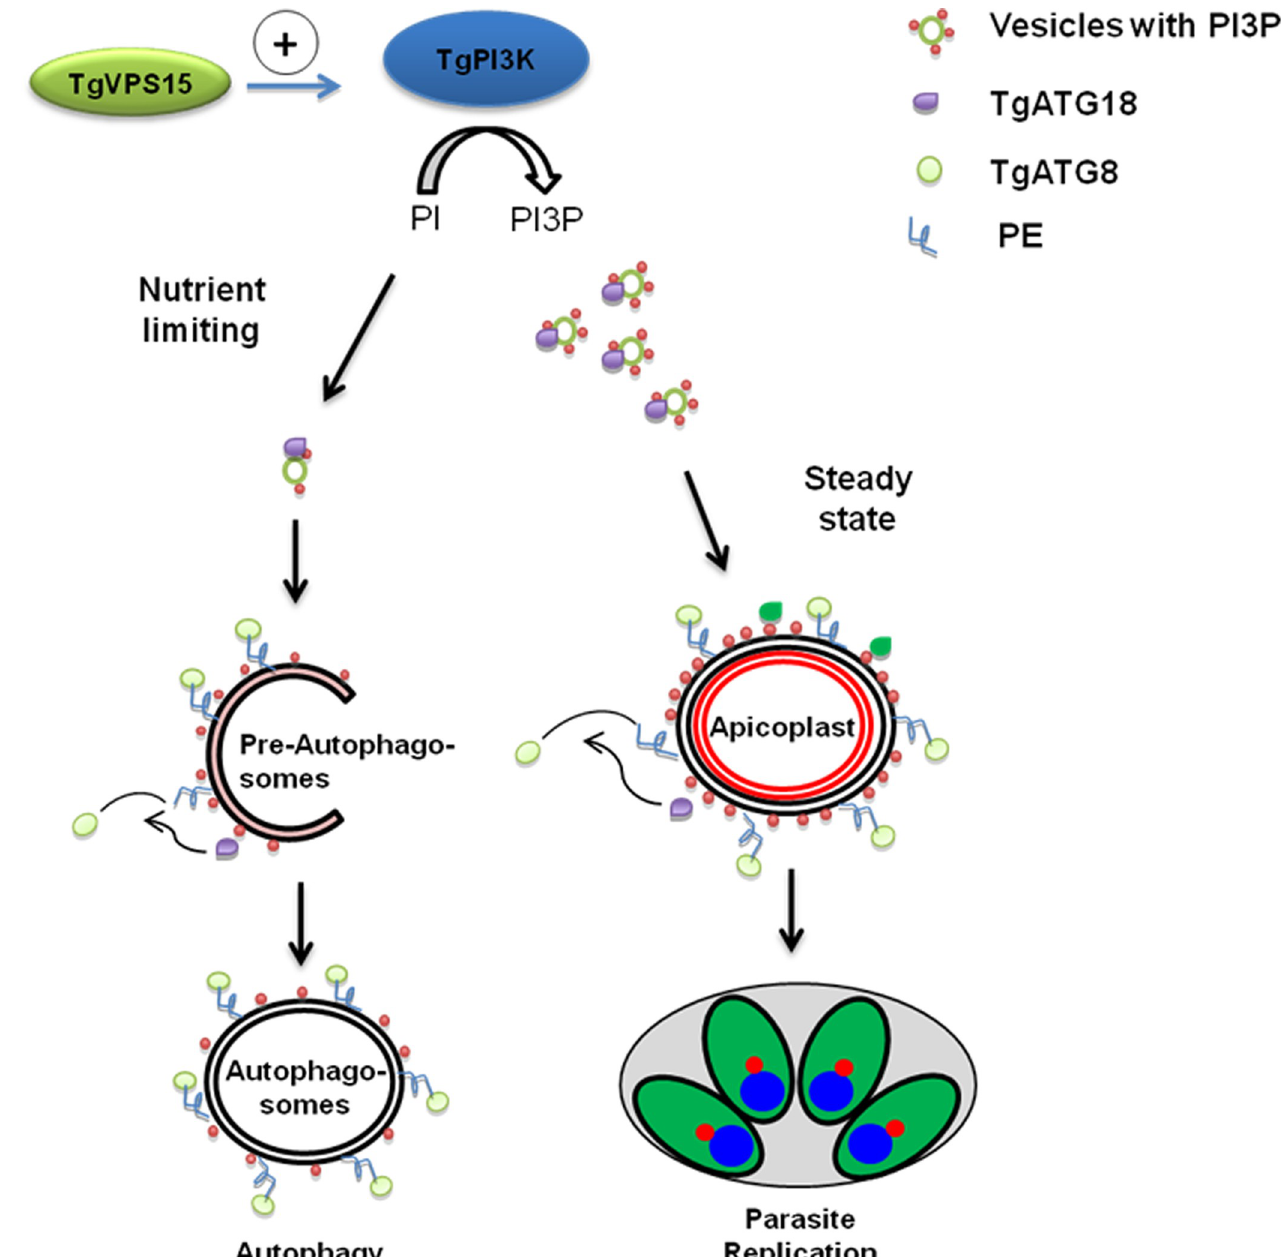
Fig 8. A signaling pathway involving TgVPS15 regulates apicoplast inheritance and autophagy. TgVPS15 may regulate TgPI3K and facilitate the formation of PI3P (Fig 2B). Under steady state conditions, PI3P regulates the localization of TgATG18 to vesicular compartments (Fig 4C and 4D), which in turn promotes the trafficking of TgATG8 to the apicoplast membrane [10] and is critical for the inheritance of the apicoplast during parasite division. Under nutrient limiting conditions, TgVPS15 may facilitate the generation of PI3P via TgPI3K at pre-autophagosome-like vesicles (Fig 5E) resulting in the localization of TgATG18 to this compartment (Fig 5C and 5E), which sets the stage for the formation of autophagosome to which TgATG8 is trafficked and where it is conjugated to autophagosomal membrane (Figs 5A and 6A) and contributes to the process of autophagy. https://doi.org/10.1371/journal.ppat.1010922.g008 with 10% fetal bovine serum and 2mM glutamine at 37˚C, 5% CO in humidified incubator. 2 500nM of Shield-1 (Shld-1) was added for destabilization domain (DD) fusion proteins, 1 μ g/mlof anhydrotetracycline (ATc) was used for TgVPS15-iKD and TgATG18-iKD parasites.